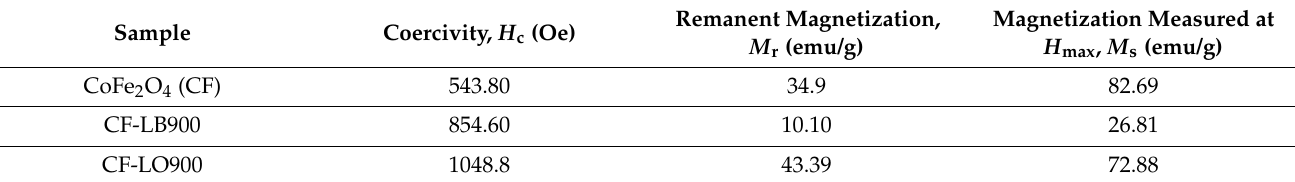
Figure 7. Magnetization as a function of applied field (M − H) hysteresis curves obtained for ferrite and hybrid materials, respectively. Table 4. Magnetic parameters of ferrite-lignin hybrids synthetized at 900 ◦